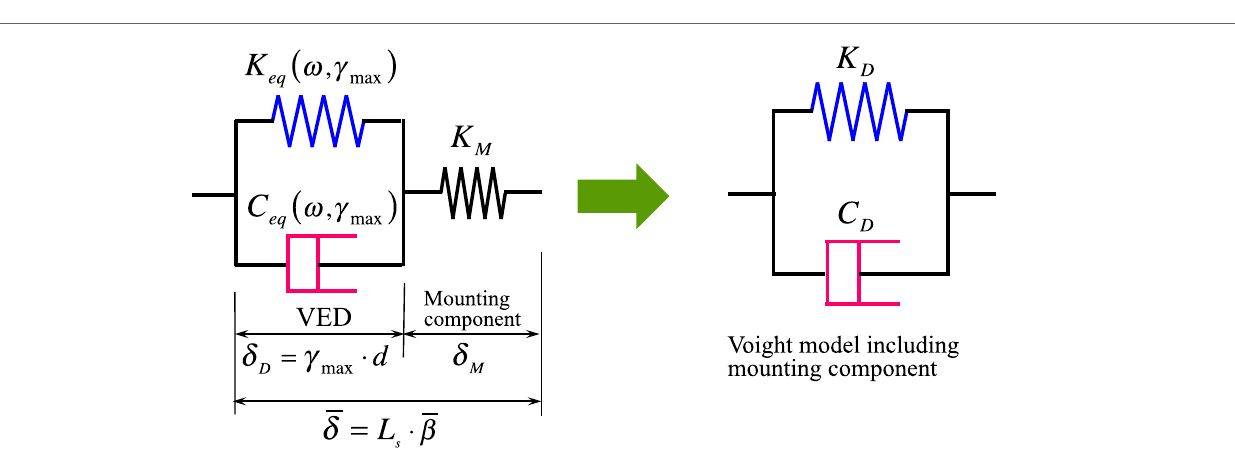
FIGURE A2 | Equivalent linearization of VED considering the mounting component’s stiffness